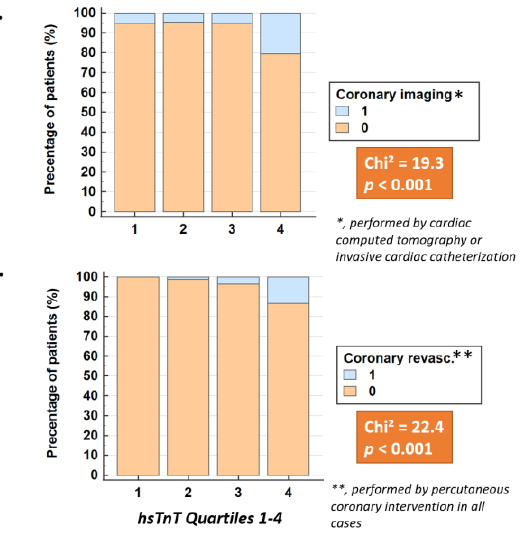
Figure 2. HsTnT quartiles were associated with subsequent coronary imaging by CCTA or invasive angiography ( a ) and with PCI ( b ) in patients with claudication ( p < 0.001 for both).